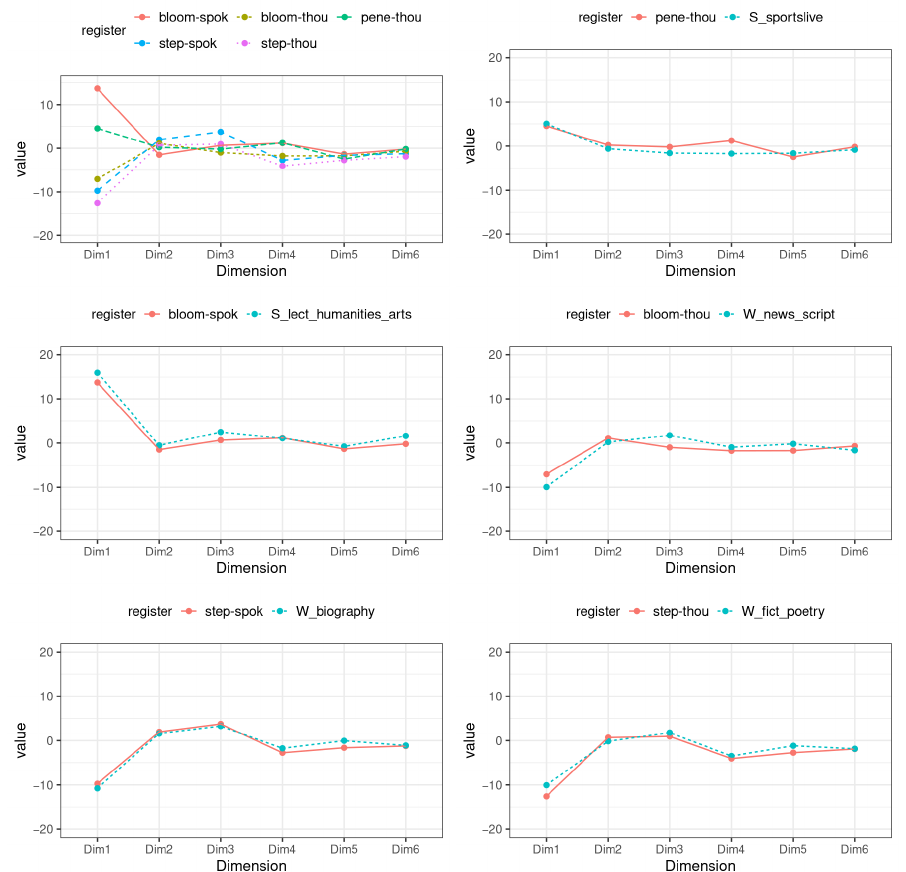
Figure 1. Dimension scores according to the MAT, for all genre/mode combinations and indi- vidual speakers with the most similar BNC genre (mean value): Molly/thoughts, S_sportslive ( top right ); Bloom/speech, S_lect_humanities_arts ( middle left ); Bloom/thoughts, W_news_script ( middle / right ); Stephen/speech, W_biography ( bottom left ); Stephen/thoughts, W_fict_poetry ( bottom right ).